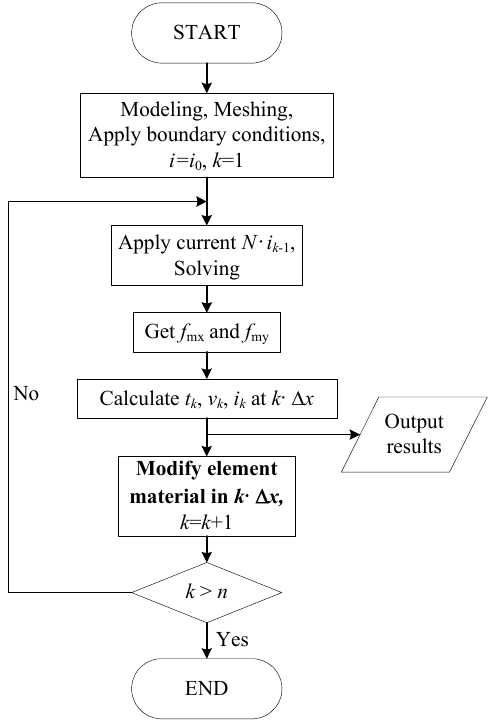
Figure 9. Flowchart for solving the dynamics by improved FEM.